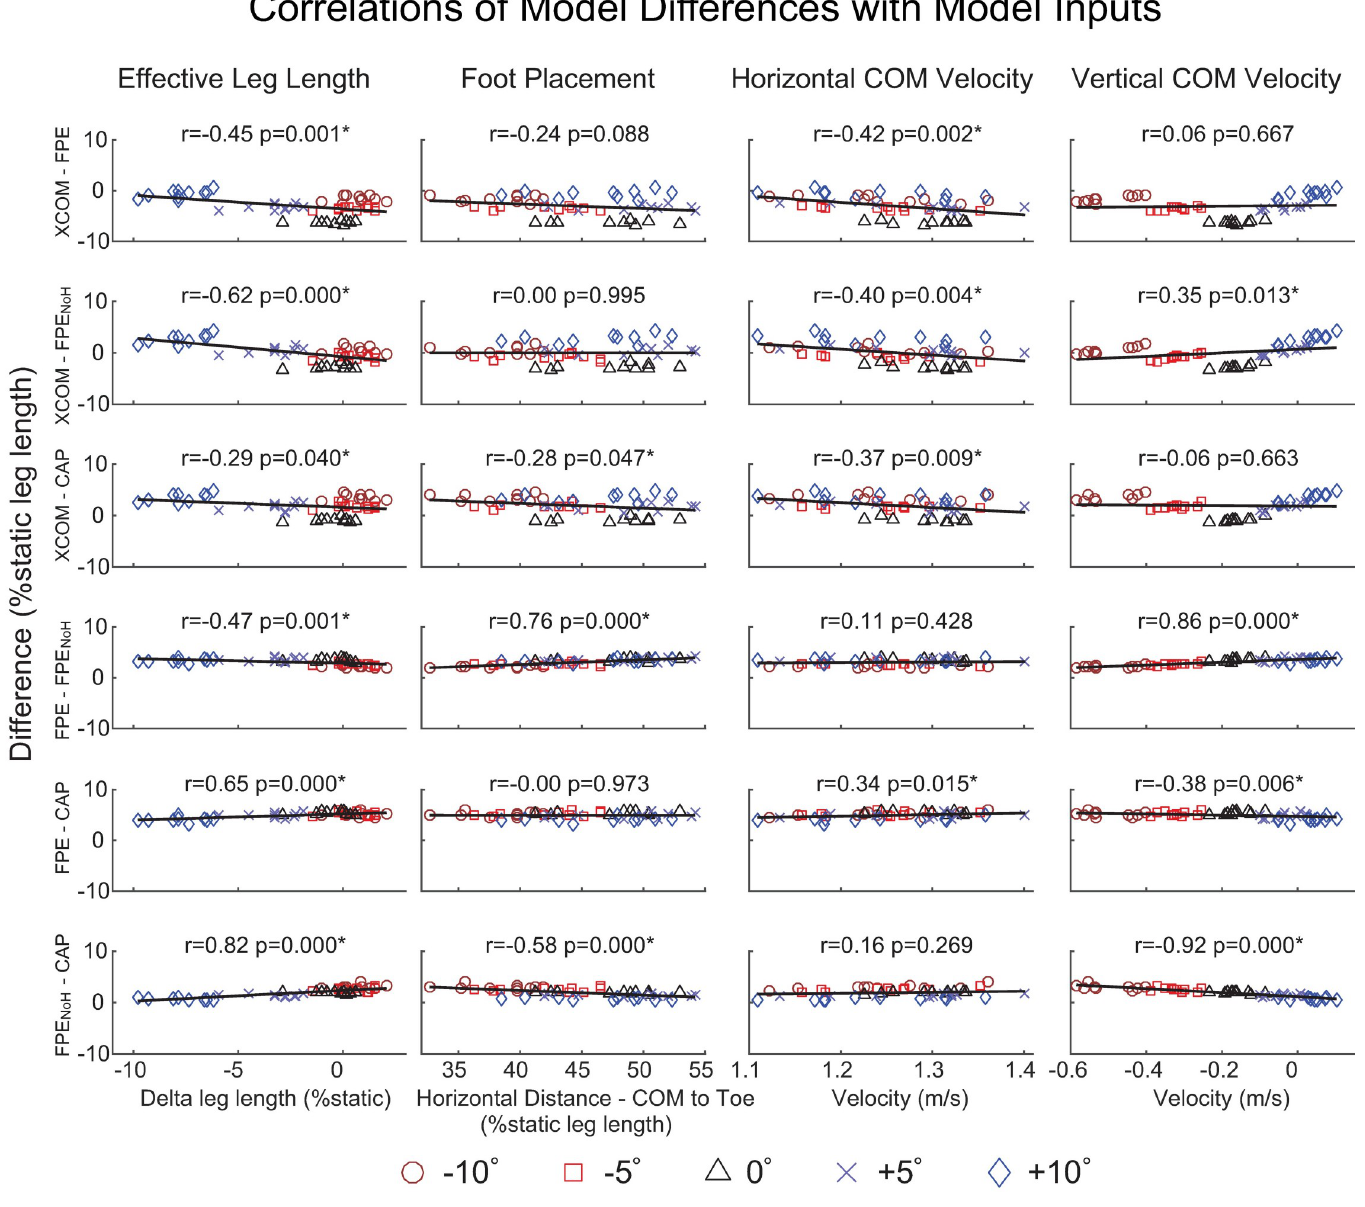
Fig 5. Correlation between differences in stability metrics and model inputs. Correlation between the signed differences between each pair of stability metrics and various inputs that affect model predictions. Effective leg length is the distance from the body center of mass (COM) to the ankle joint center at the instant of heel strike. Foot placement refers to the horizontal (i.e., anteroposterior) distance between the body COM and toe marker at the instant of heel strike. Each stability metric was normalized to percent static (i.e., standing) leg length. Mean values for each subject are plotted for each ramp angle: -10˚ (red circles), -5˚ (red squares), 0˚ (black triangles), +5˚ (blue crosses), and +10˚ (blue diamonds). Pearson correlation coefficients (r) and p -values are given for each subfigure. Statistically significant correlations are indicated by �